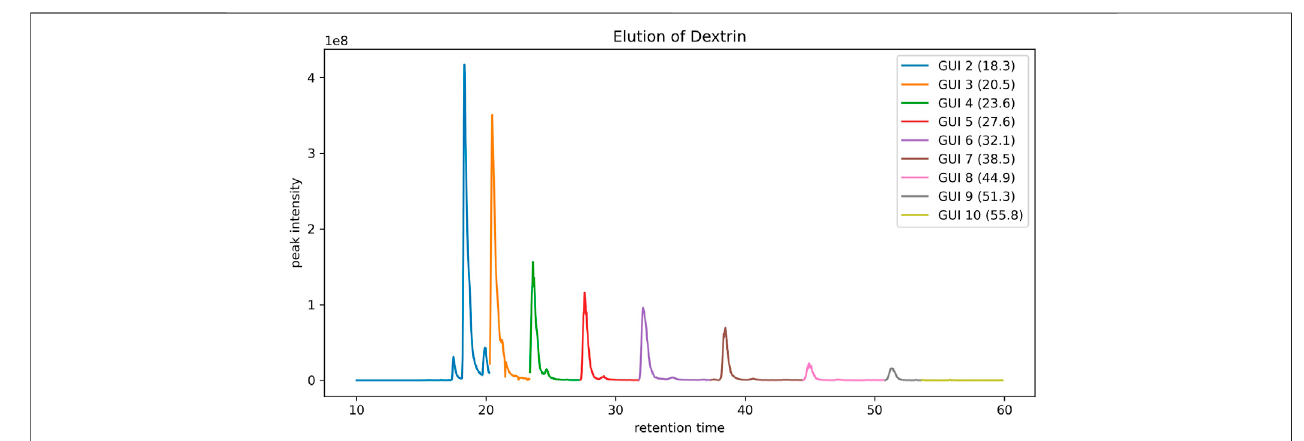
FIGURE 2 | The elution pro fi le of dextrin ladders extracted by using peak matching and the dynamic programming algorithm.